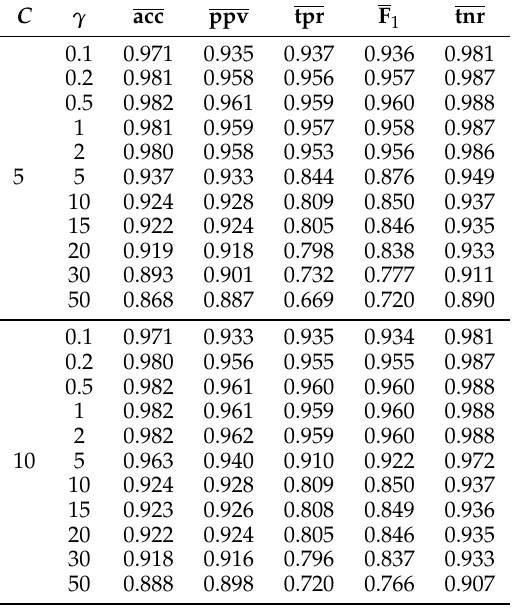
Figure 6. Performance measures (per-unit) corresponding to the k NN strategy for the multiclass classification problem with respect to the number of neighbors k (horizontal axis). Table 6. Performance measures (per-unit) corresponding to the quadratic SVM strategy for the multiclass classification problem using different box constraints ( C ) and different kernel scales ( γ ). The cases with the best performance of each measure are highlighted in